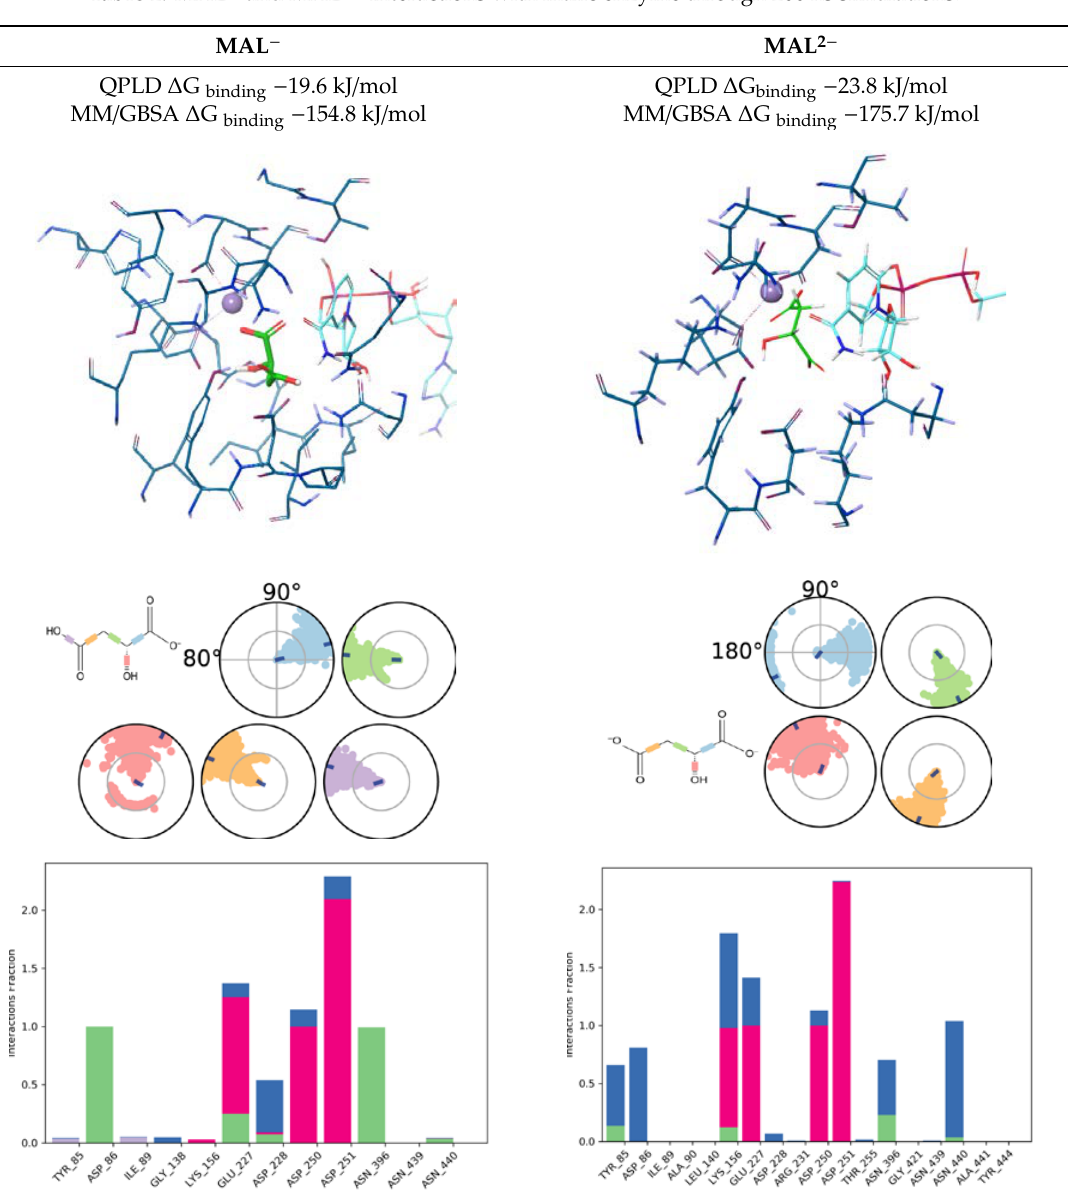
Table 2. MAL − and MAL 2 − interactions with malic enzyme through 200 ns simulations.